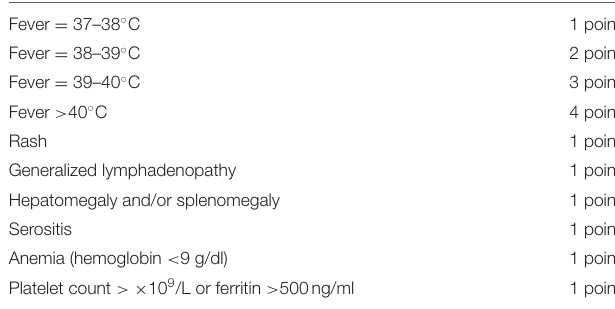
TABLE 1 | Systemic manifestation